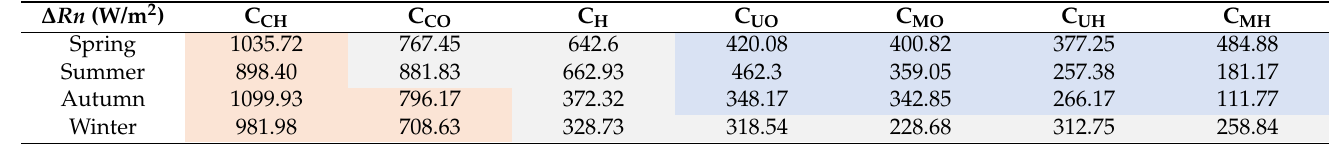
Table 3. Daily ranges of Rn ( ∆ Rn , W/m 2 ) of seven riparian plant communities during four